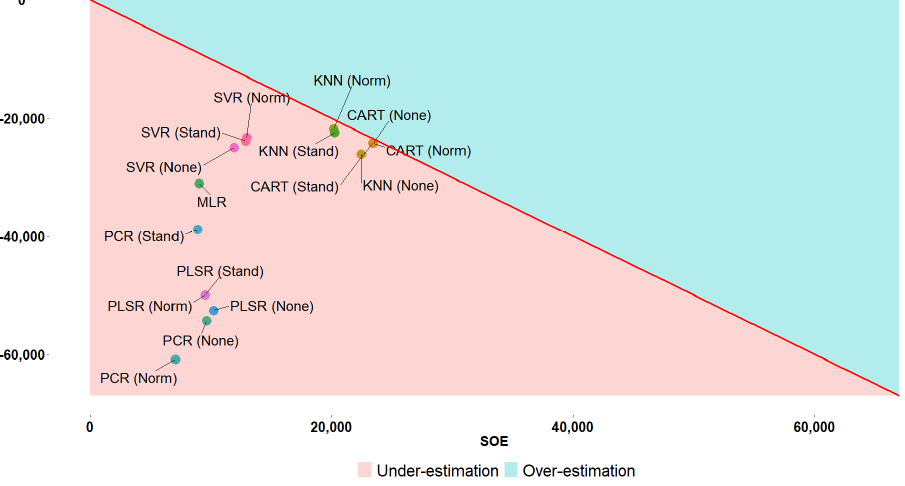
Figure 7. RROC space for the set of candidate models (combination of algorithm and FSM).